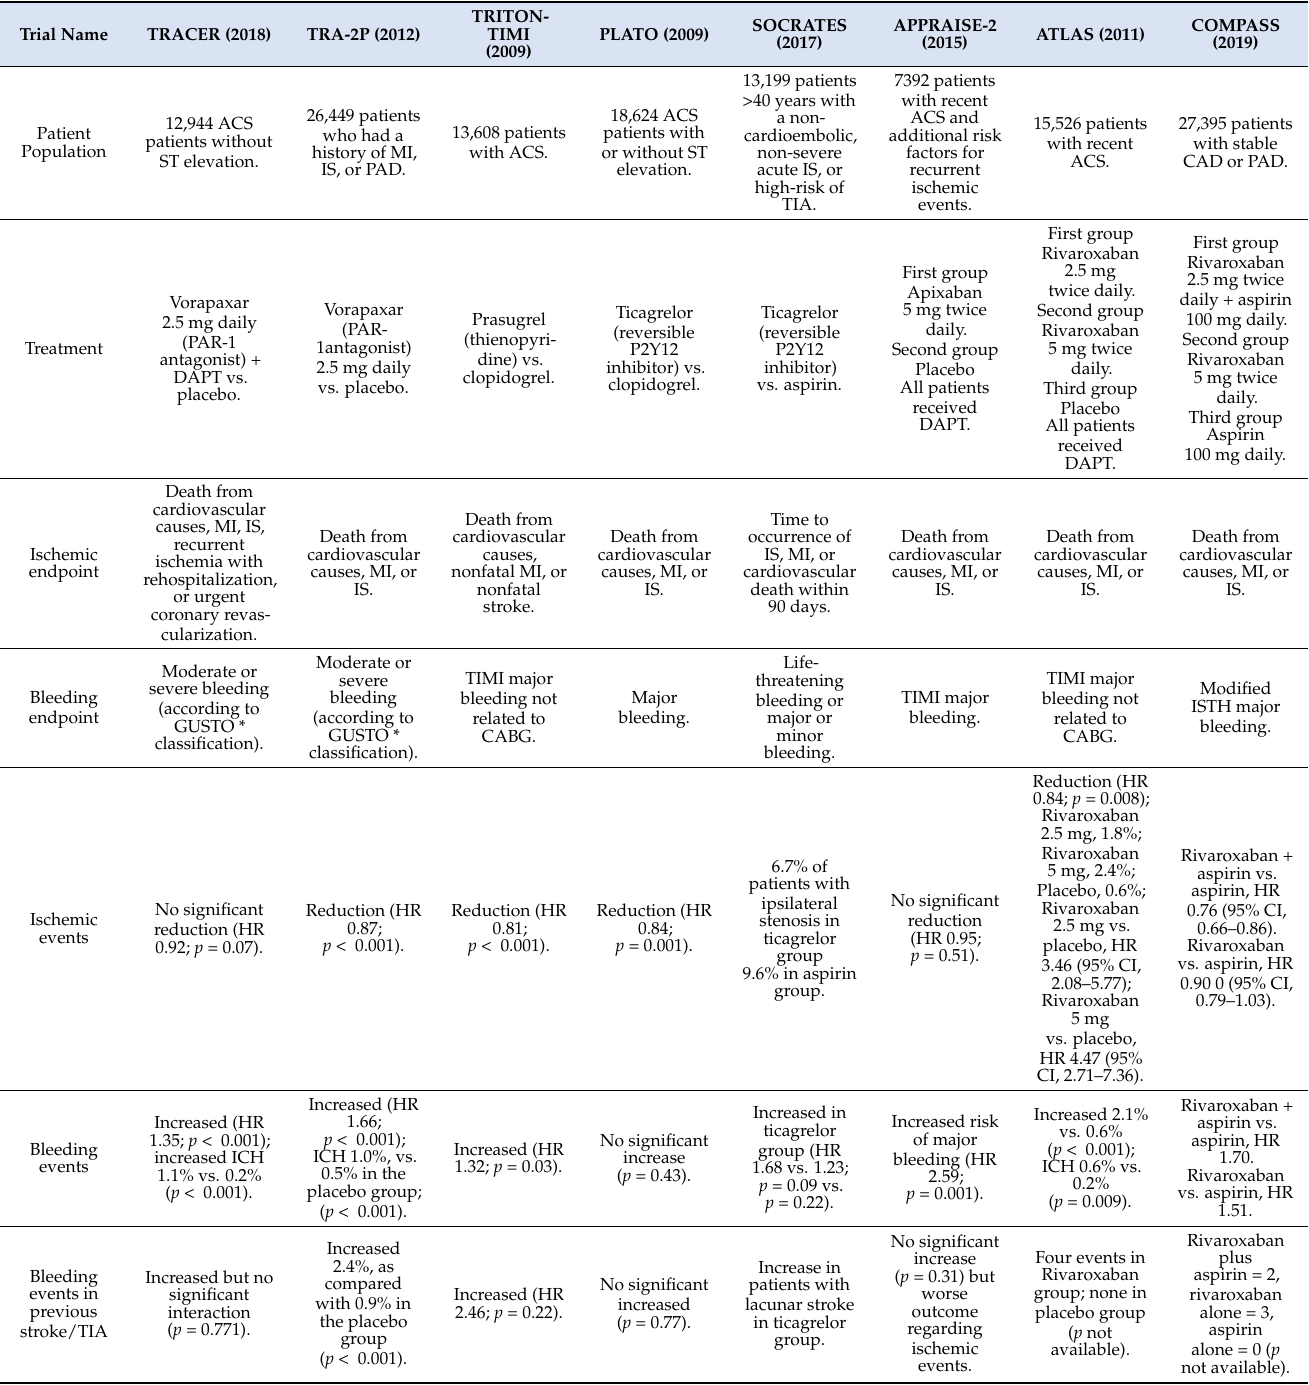
Table 1. Trials of combined antithrombotic drugs in coronary artery disease (CAD)